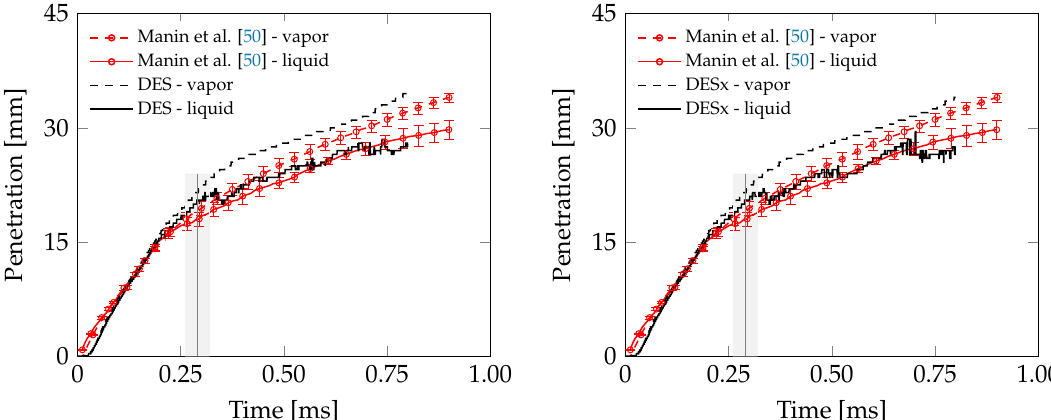
Figure 5. Liquid and vapor penetrations as predicted by DES ( left ) and DESx ( right ) simulations on the coarse mesh (minimum grid size equal to 0.25 mm) in comparison with experimental data of SNL reported in Manin et al. [50]. The gray band corresponds to the time interval in which the separation between vapor and liquid phases occurs, as predicted by the numerical simulation.